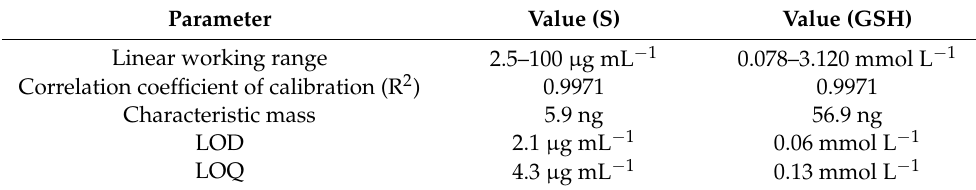
Table 4. Analytical performance parameters of the elaborated